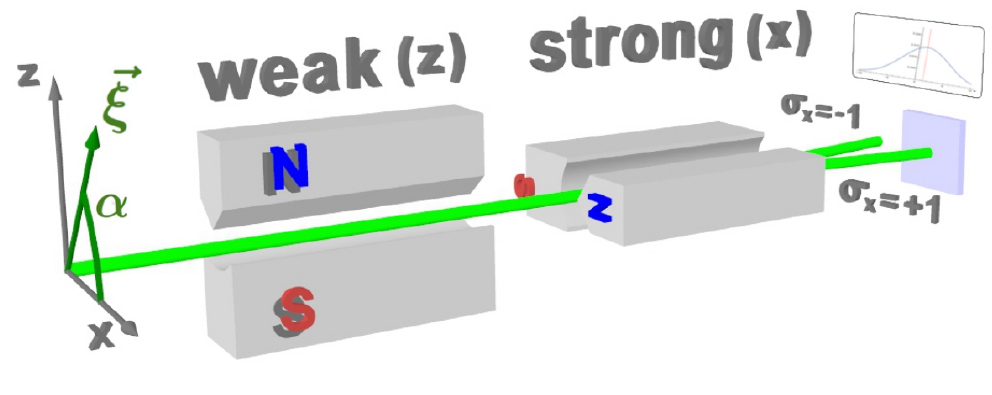
Figure 1. Original setup for weak spin measurement of spin 1 / 2 -particles, proposed by AAV. After the weak interaction, the sub beams belonging to ˆ σ ± z are still overlapping by a large